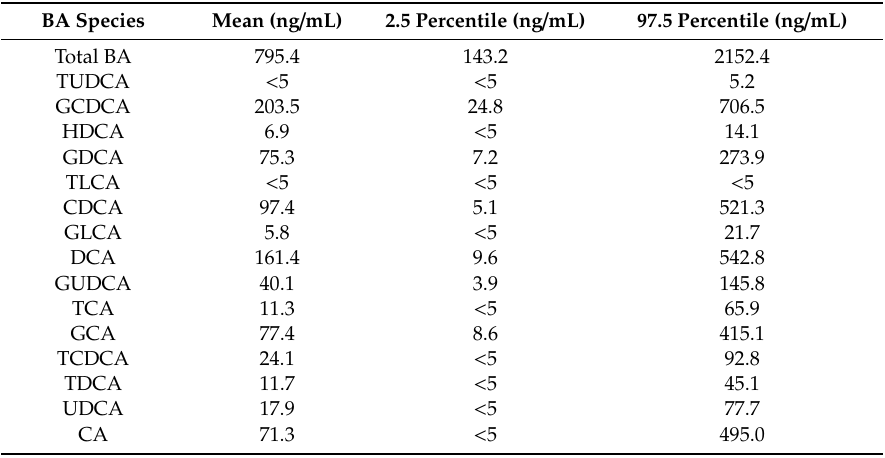
Table 2. Serum concentrations of individual bile acids (BA) in healthy adult population.